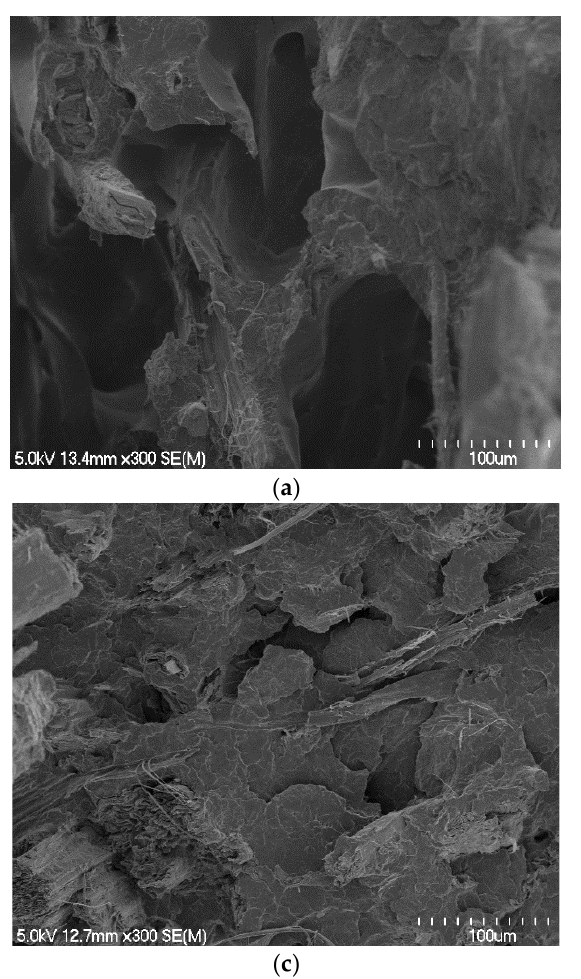
Figure 8. Scanning electron micrographs of tensile fracture surfaces of composites containing approximately 40 wt% fibre contents made with polymer sheets of: ( a ) 0.66, ( b ) 0.56, and ( c ) 0.29 mm.